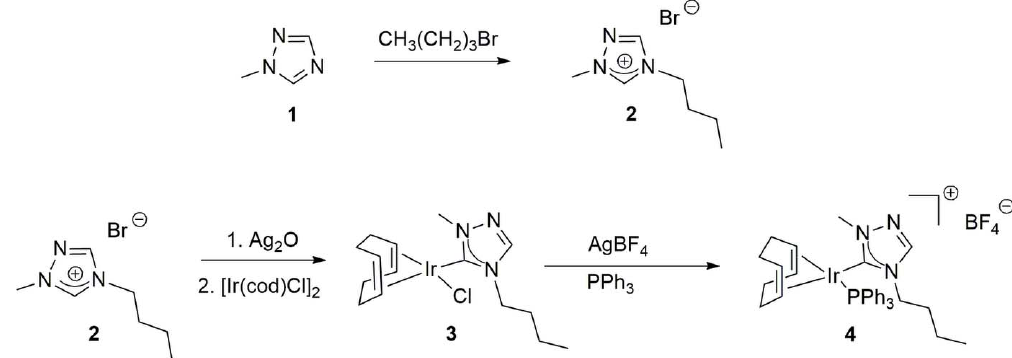
Figure 4 Reaction scheme for the synthesis of the N-heterocyclic carbene ( 2 ) and subsequent formation of the title compound ( 4